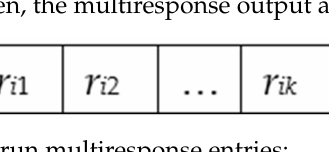
Controlling Factors